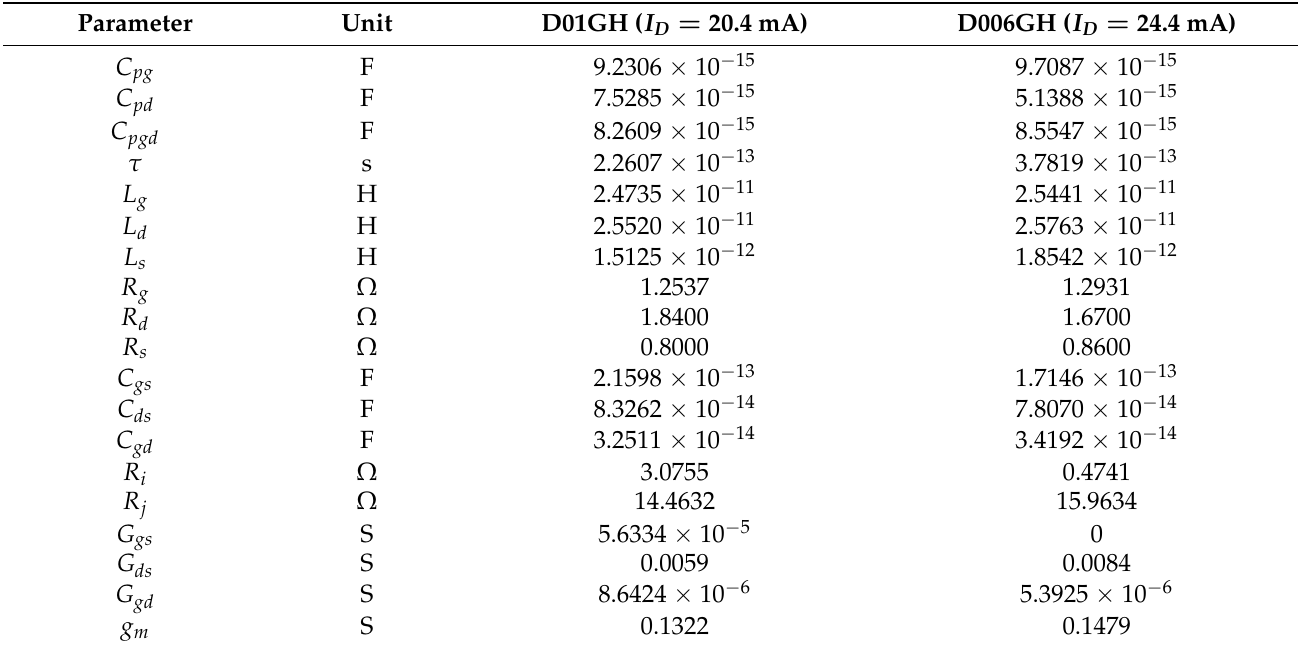
Figure 5. S-parameters of 4x050 devices up to 50 GHz: ( a ) D01GH, V DS = 5 V, I D = 20.4 mA ( b ) D006GH, V DS = 5 V, I D = 24.4 mA. Table 2. Sample values of SSEC elements at V DS = 5